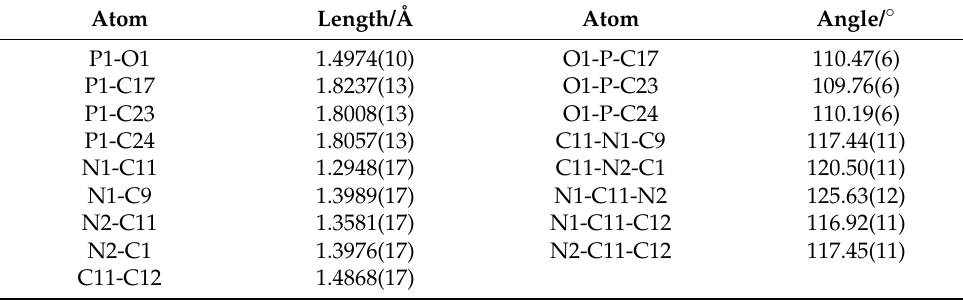
Figure 1. ORTEP diagram of L1 with the thermal ellipsoids drawn at the 50% probability level. Atom colours: (a) blue = nitrogen, (b) white = hydrogen, (c) red = oxygen, (d) orange = phosphorus, (e) grey = carbon. Table 1. Selected bond length (Å ) and angles (°) of L1.